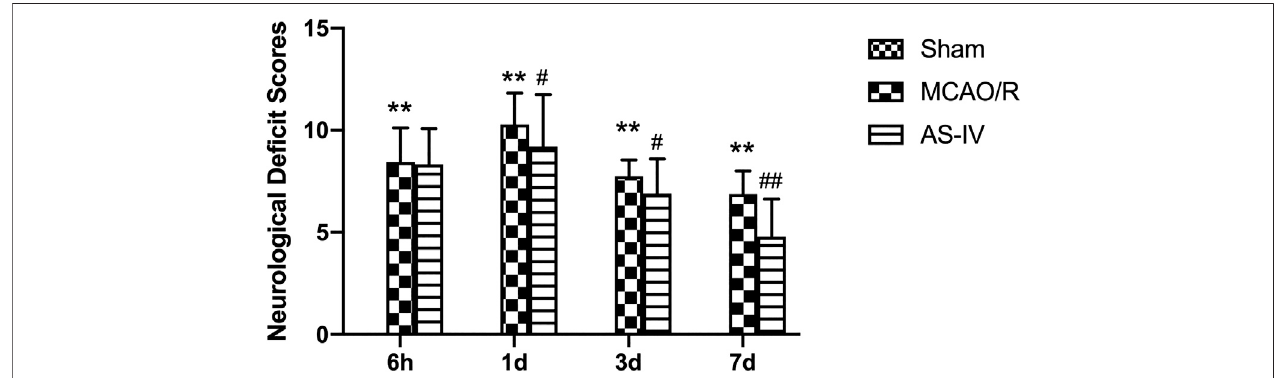
FIGURE2| Theneurologicalde fi citscores(NDS)inShamgroup,middlecerebralarteryocclusion/reperfusion(MCAO/R)groupandAstragalosideIV(AS-IV)group at6h,1d,3d,and7daysafterCIRinjuryinrats(mean ± SD, n (cid:1) 12).** p < 0.01,comparedwiththeShamgroup;# p < 0.05,## p <